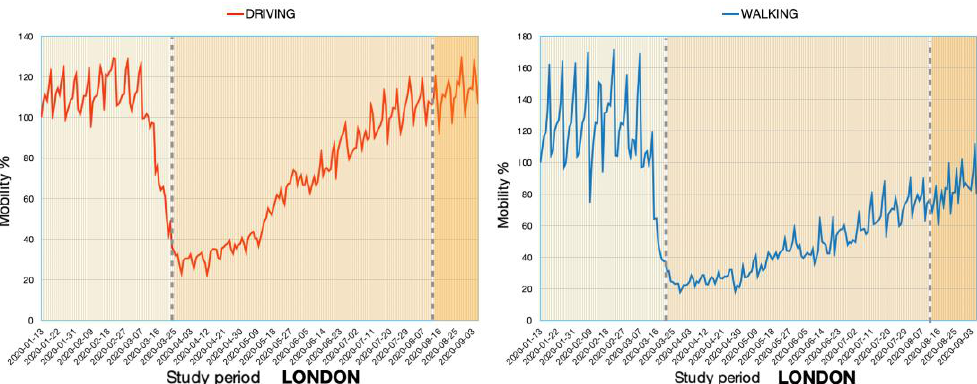
Figure 14. Mobility evolution in London from January 2020 until September 2020. Source: Own elaboration with data collected from Apple ’s mobility trend [22].